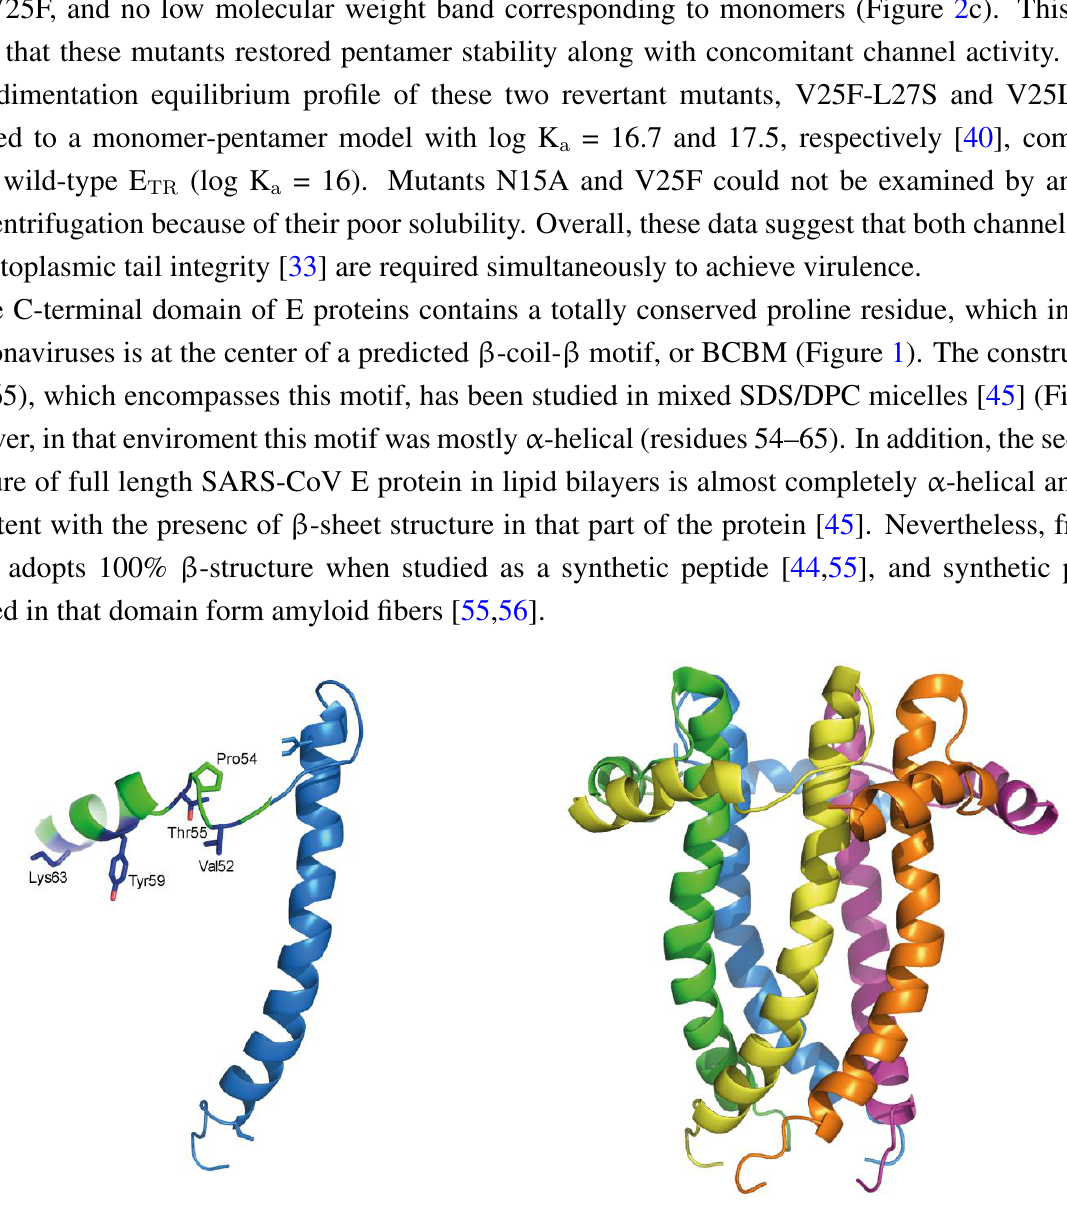
Figure 3. Structural model of SARS-CoV E. ( a ) Solution NMR-based model of E